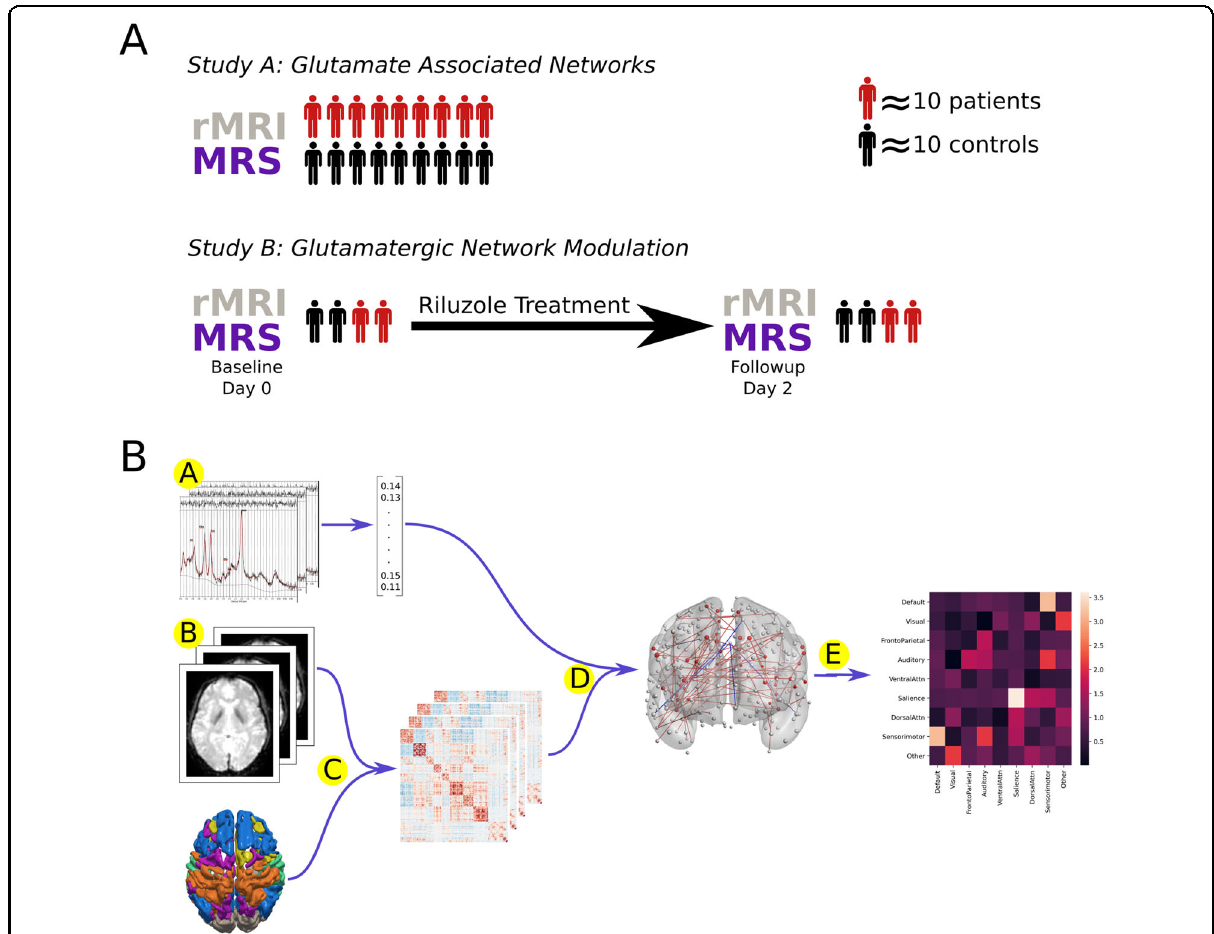
Fig. 1 Overview of methods. A Two cohorts of subjects are reported, Study A consists of patients and controls who received rs-fMRI and 1H-MRS, Study B consists of patients and controls who received rs-fMRI and 1H-MRS both before and after 2 days of riluzole treatment. B A, 1H-MRS provides a single scalar value for each subject. B, rs-fMRI data is gathered from the same subjects. C, Time series extracted from 333 cortical nodes and correlated to produce a connectivity matrix. D, Network Based Statistic used to identify functional connectivity network associated with neurochemical measure. E, This neurochemical associated network is characterised on the basis of number of edges shared with canonical resting state